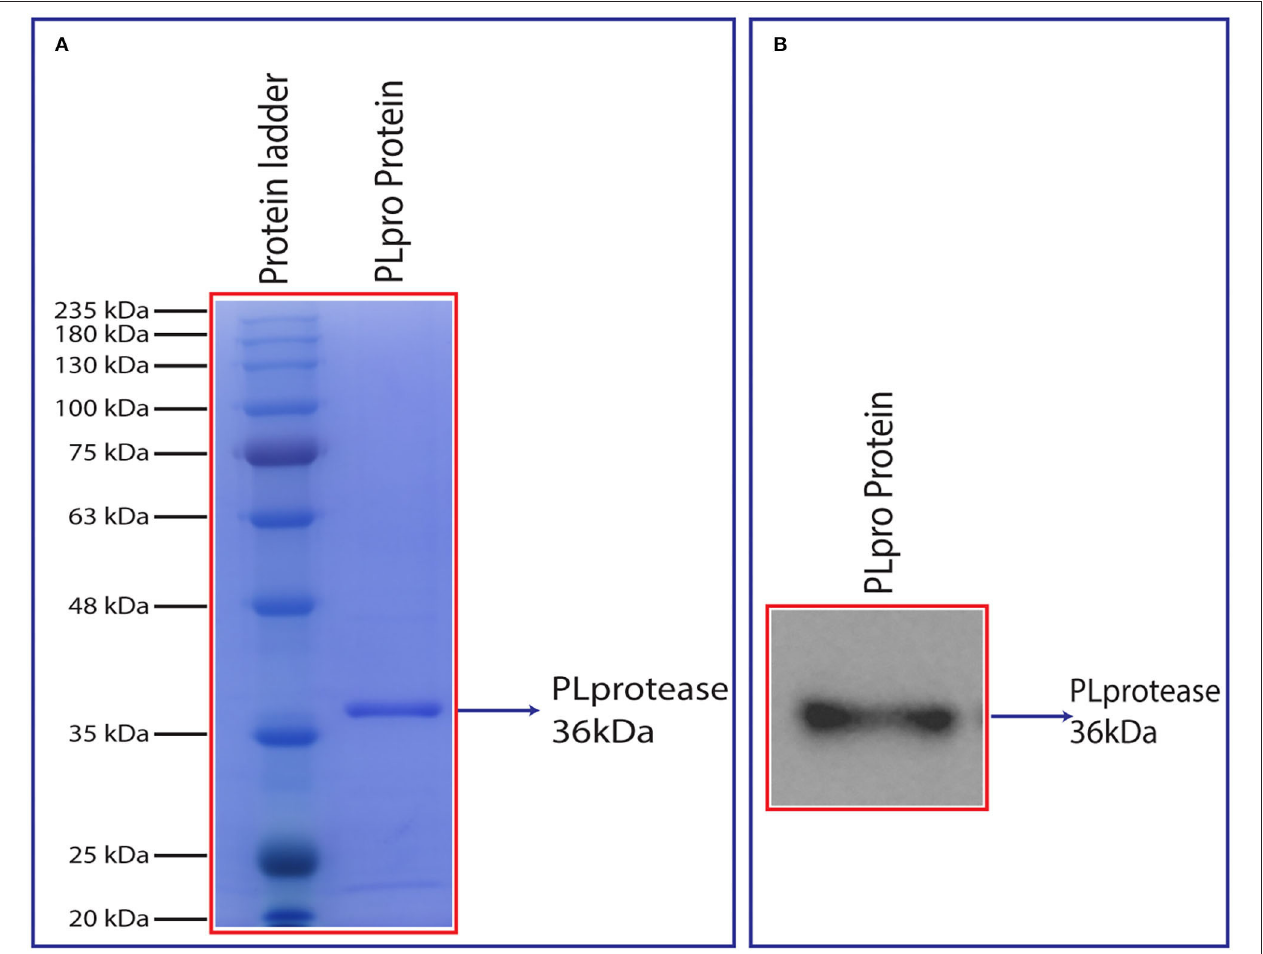
FIGURE 4 | (A) SDS-PAGE analysis of purified PLpro after size exclusion chromatography and (B) chemiluminescent detection of the recombinant PLpro using anti-His IgG (6x) antibody in a western blot. Synthesized PLpro clones were transformed, expressed in 2X YT media at 18 ◦ C with 0.5mM IPTG and 1mM ZnCl 2 for 20h. The harvested pellet was lysed, sonicated, and centrifuged at 19,496g for 1h. The cell supernatant was passed through HisTrap FF column and protein eluted with linear gradient imidazole. The eluted fractions were analysed by SDS and western blot followed by the protein that was loaded into HiLoad 26/600 Superdex 200 pg column for further purification. The purity of the protein was analysed using 12% SDS-PAGE and confirmed by western blot ( ∼ 36